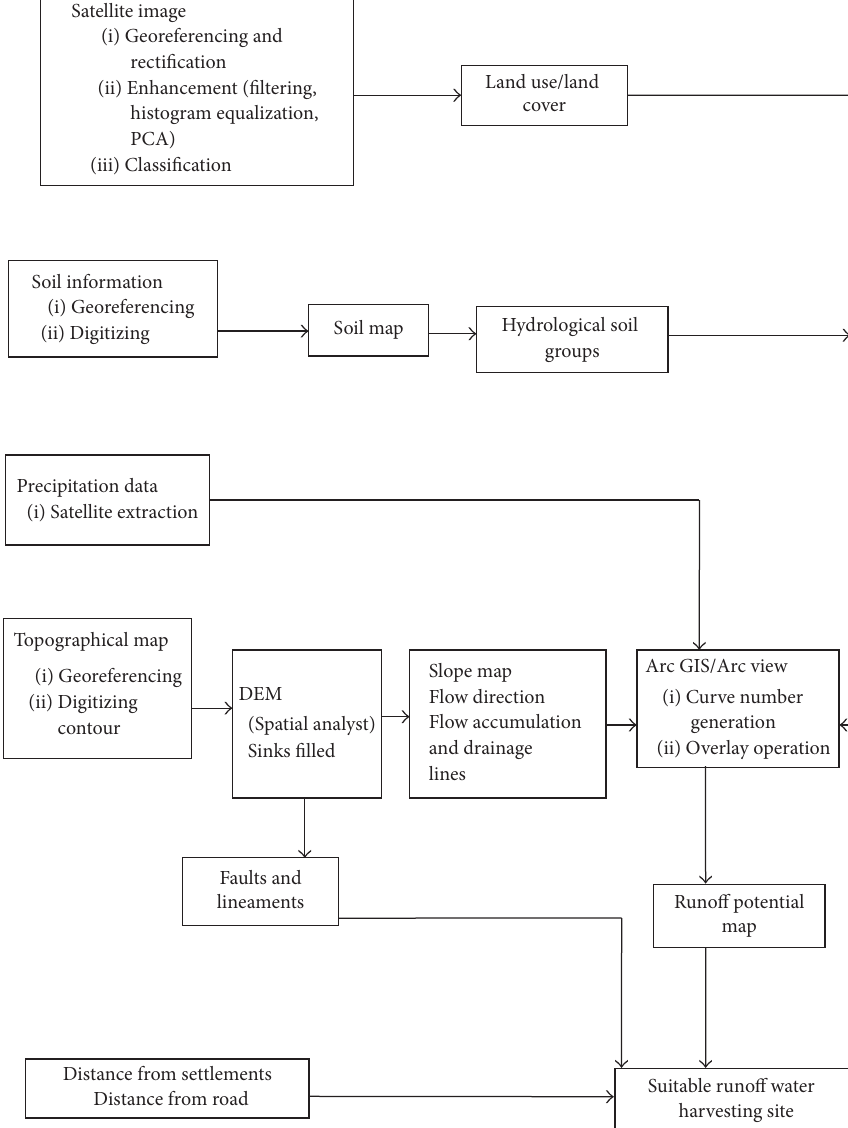
Figure 1: Methodology adopted for